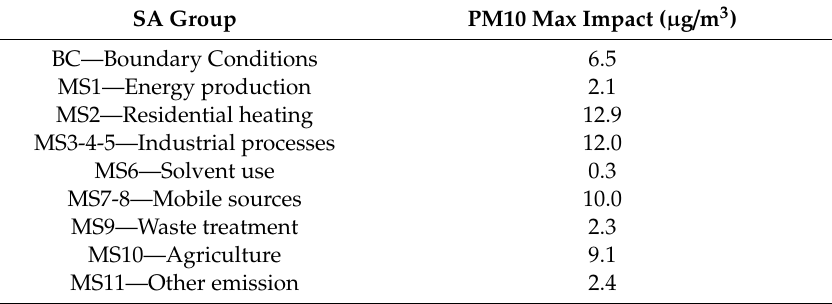
Table 2. Maximum impacts of source apportionment (SA) groups on PM10 average concentration in Lombardia ( µ g / m 3